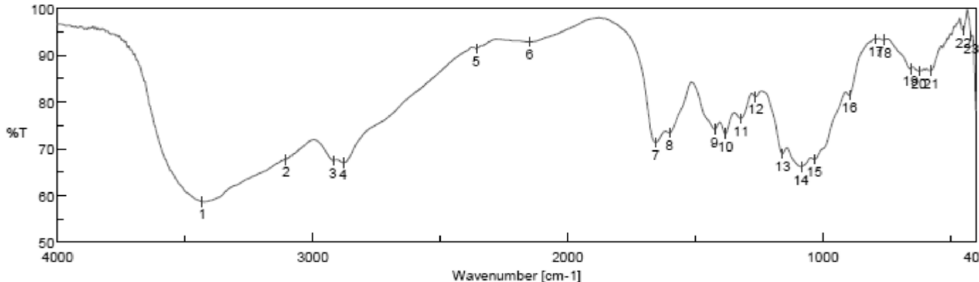
Figure 5. Fourier transform infrared spectroscopy analysis (FTIR) of chitosan nanoparticles (CSNPs) with various components.